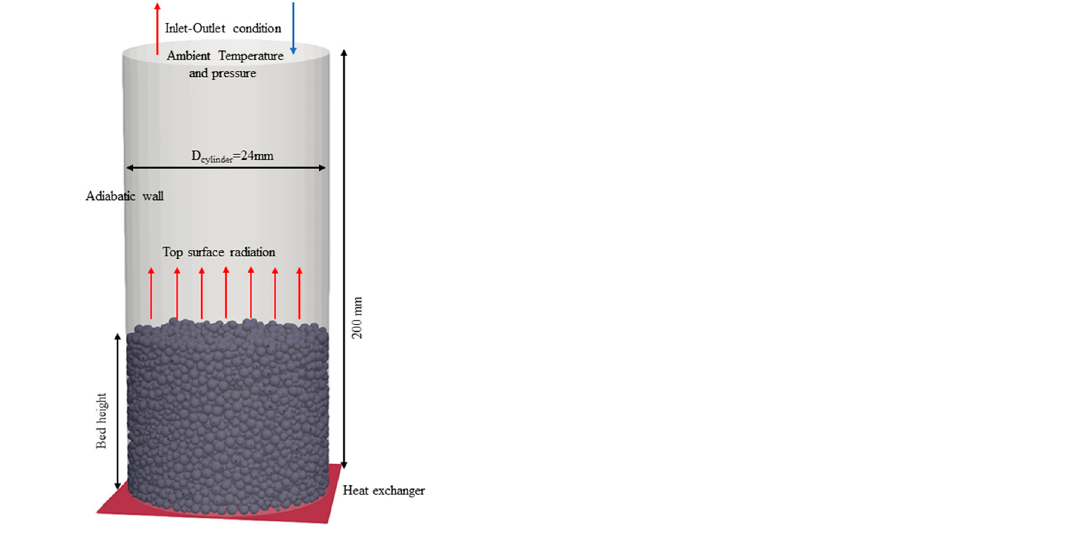
Figure 29. Simulation setup for the 3-D packed beds [269]: Reprinted with permission from Ref. [269] Copyright © 2021 Elsevier Ltd. All rights reserved.